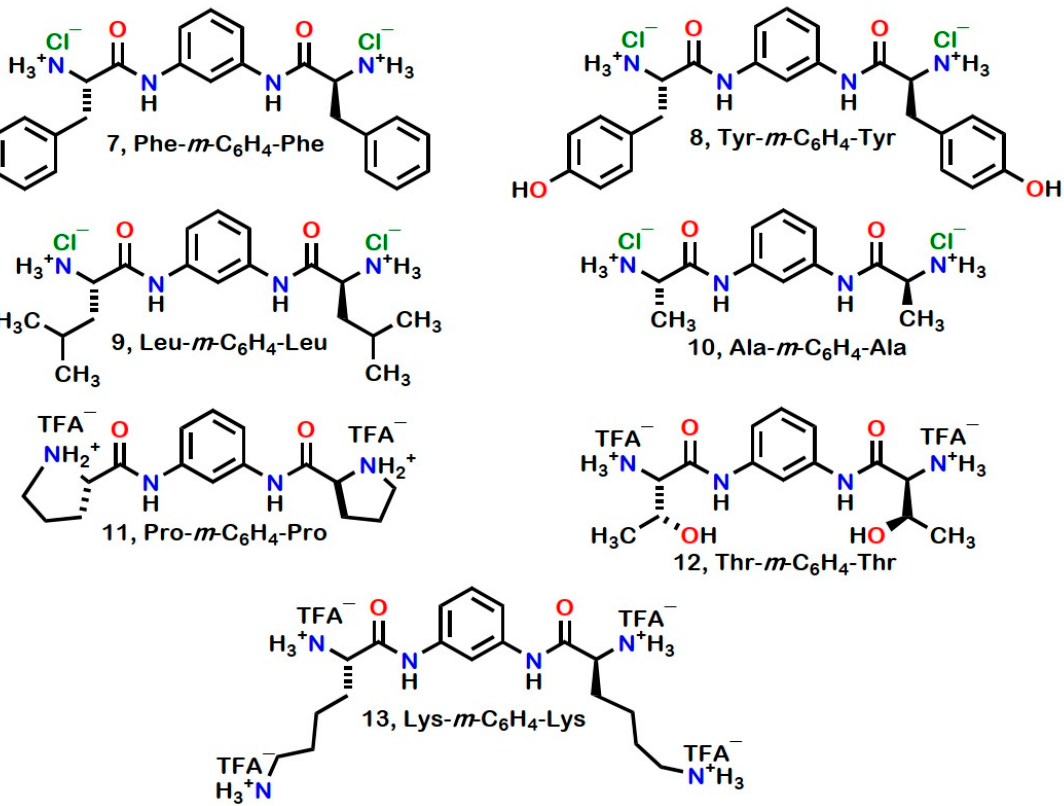
Figure 8. Bis (amino acid) compounds were prepared and used for the present study. All of the new bis (amino acid) compounds or their salts were obtained as colorless solids. They were fully characterized by spectral methods that were found to be in agreement with their assigned structures.